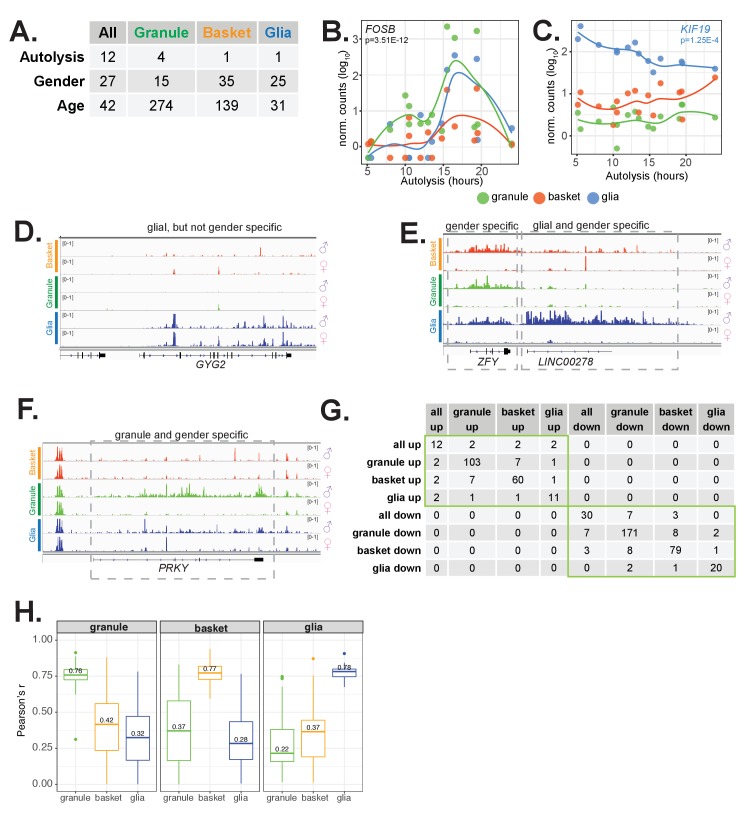
Analysis of clinical factors that contribute to gene expression variability across individuals, related to Figure 6.(A) Table showing the number of differentially expressed genes (adjusted p<0.01, baseMean >50) for all cell types or each cell type individually when samples are stratified by clinical factors. For age and postmortem delay (PMD), numerical covariates were used for differential expression analysis. Gender indicates male versus female comparison. (B,C) Examples of genes that vary in expression depending on PMD. (B) FOSB is elevated in glia, granule, and basket cells in a few samples with intermediate PMDs. (C) KIF19 expression in glia declines as sample PMD increases. (D–F) Browser views showing expression of gene expression across males and females and in each cell type. Minimum and maximum scale values are indicated. Each track is a merged view of all samples corresponding to the indicated gender and cell type. (D) Expression of the autosomal gene GYG2. (E,F) Example of gender and cell-type specific genes in glia (E) and granule cells (F). Expression of PRKY in (F) is highest in granule cells, at intermediate levels in glia, and low in basket cells. (G) Table showing the number of genes that are in common between eight groups of differentially expressed aging genes. No overlaps were found between age up-regulated genes from any cell type and down-regulated genes from any other cell type. (H) Boxplots showing the distribution of Pearson’s correlation (r) values between gene expression and age. Correlations with age were computed using expression values from granule cells (green), basket cells (orange), and glia (blue) for 274 granule (left panel), 135 basket (middle panel), and 31 glial (right panel) age-associated genes. Median correlation values for each comparison are indicated.